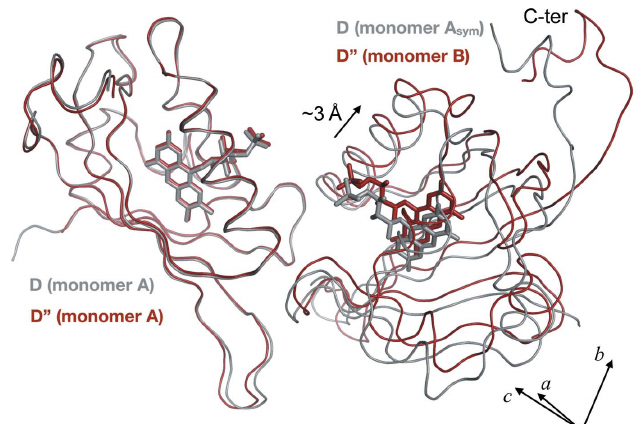
Figure 5 Comparison of the crystallographic dimer from the dark structure D (grey ribbon) with the non-crystallographic dimer from structure D 00 (firebrick ribbon). Both dimers were superposed on their chain A. A